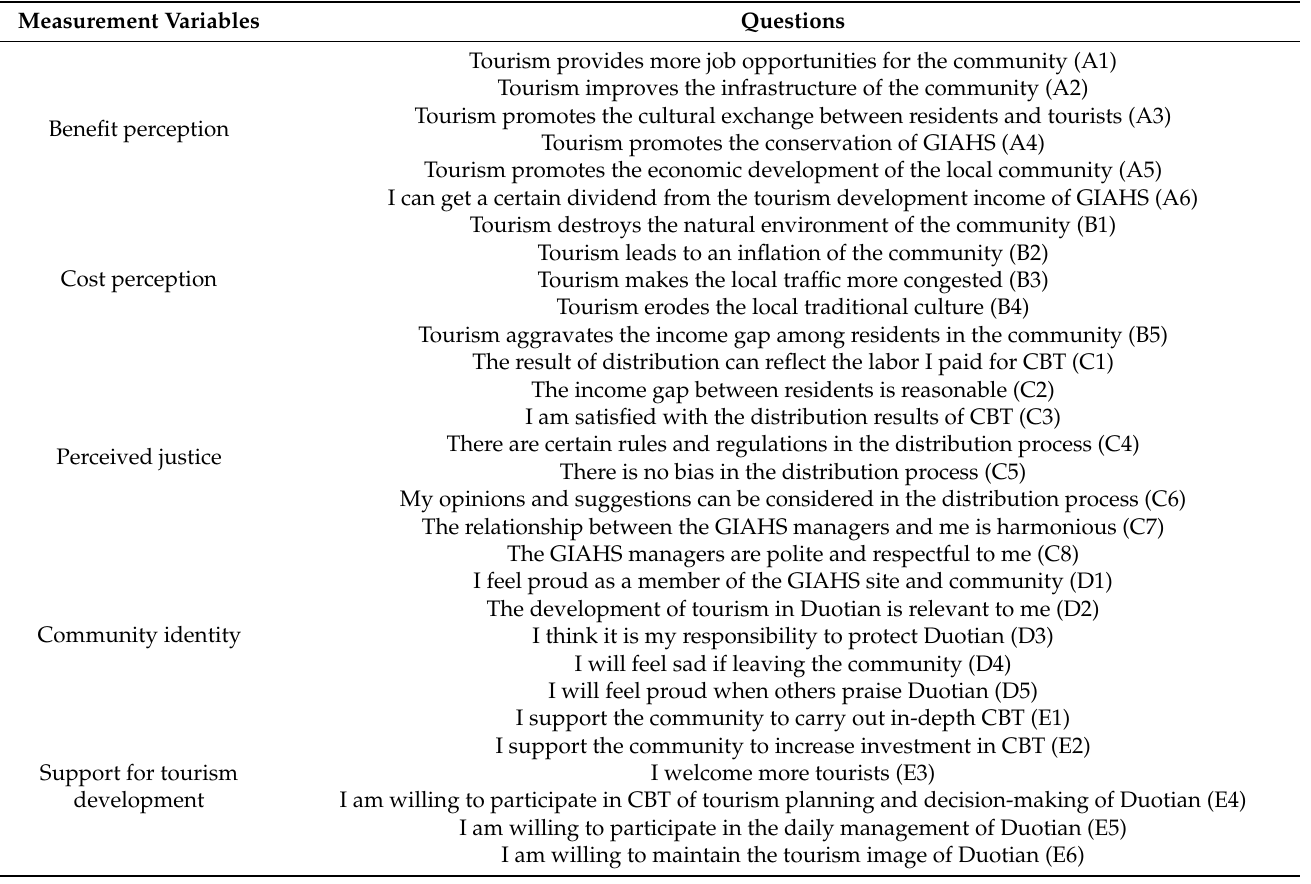
Table 1. Measurement variables and questionnaire